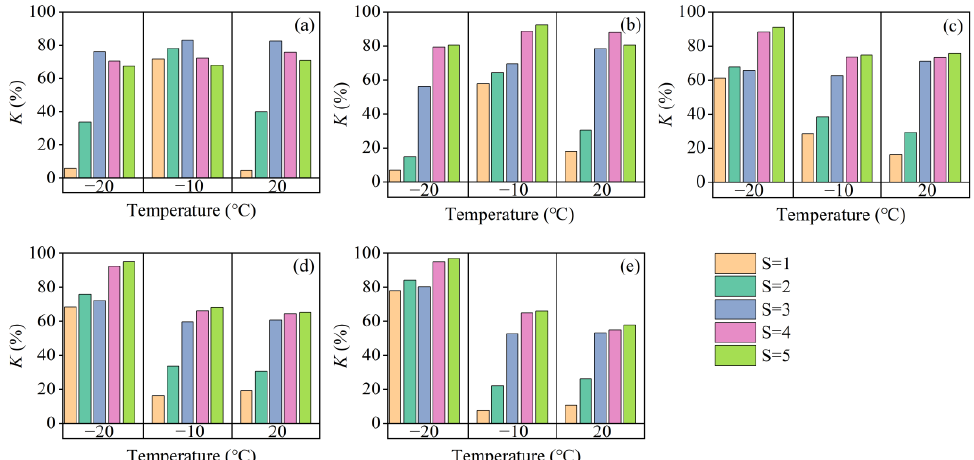
Figure 3. Rate of strength loss by salinity, with temperatures and ages. ( a ) Under the age of 3 days; ( b ) under the age of 7 days; ( c ) under the age of 14 days; ( d ) under the age of 28 days; ( e ) under the age of 90 days.